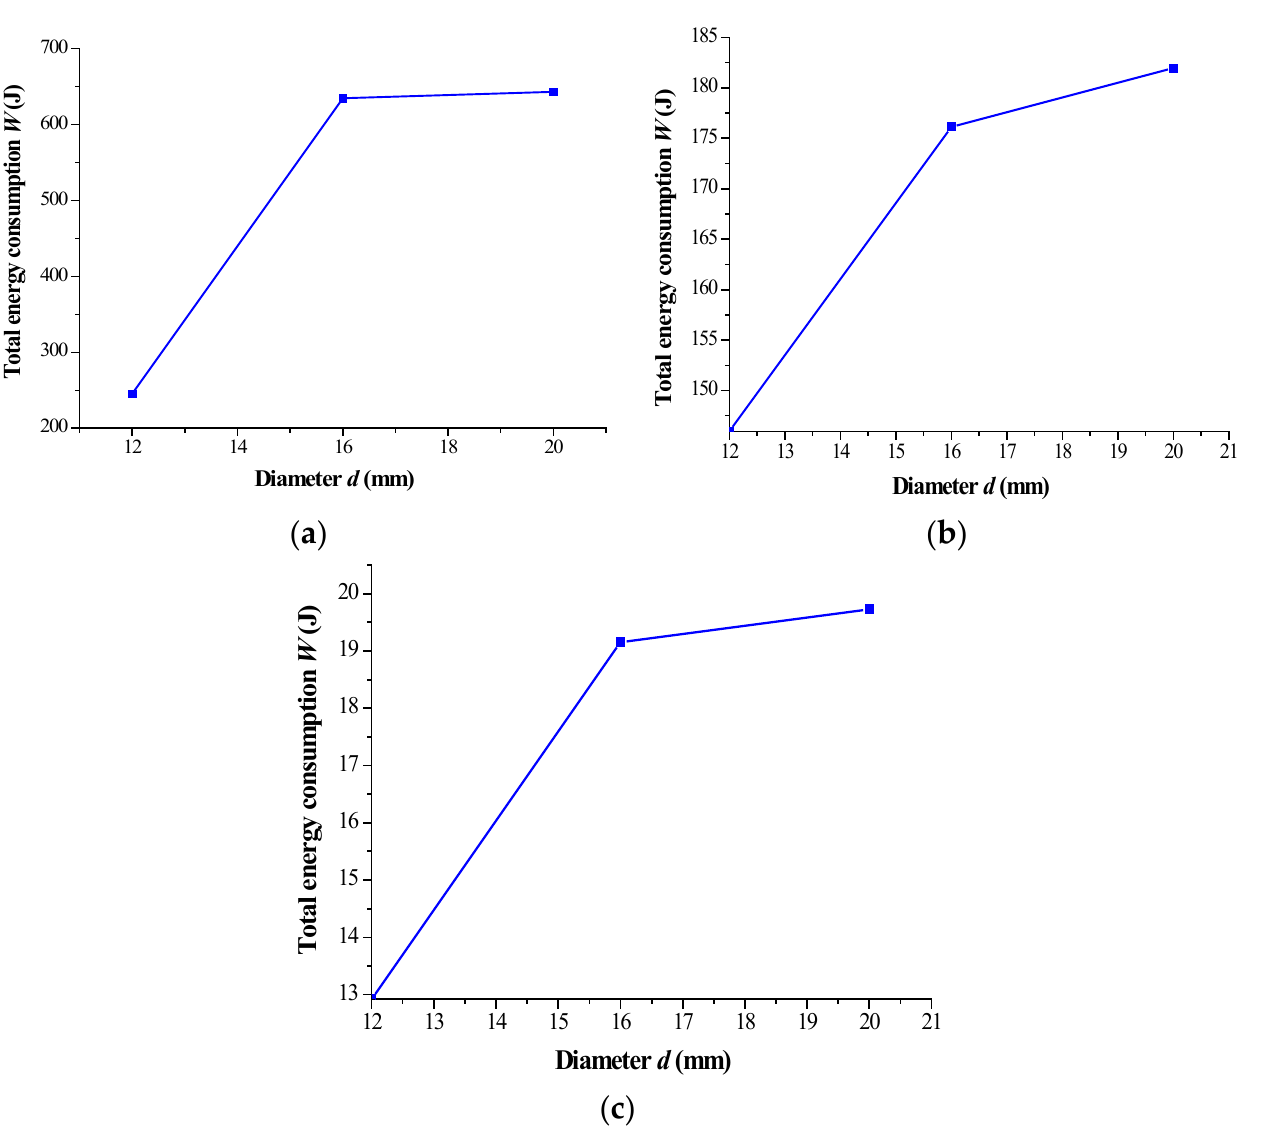
Figure 7. The relations of W–d when S 0 is 25 mm. ( a ) LWCSB-1-CRB-100; ( b ) LWCSB-3-CRB-100; ( c ) LWCSB-2-PSB-50.